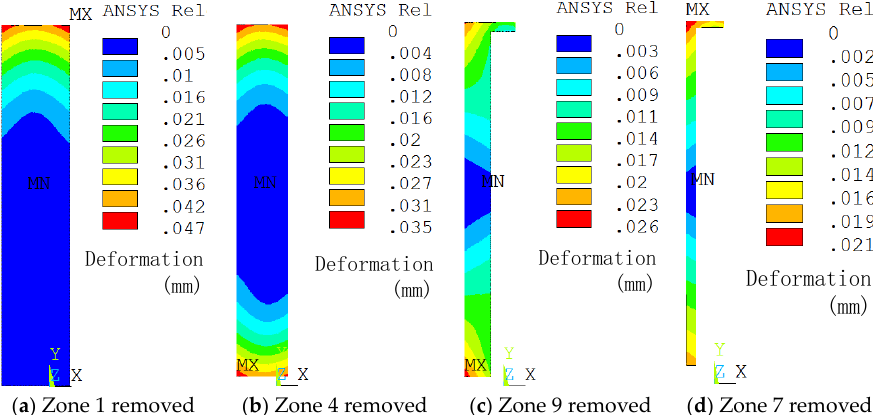
Figure 17. Maximum distortion during material removal in the optimized process.